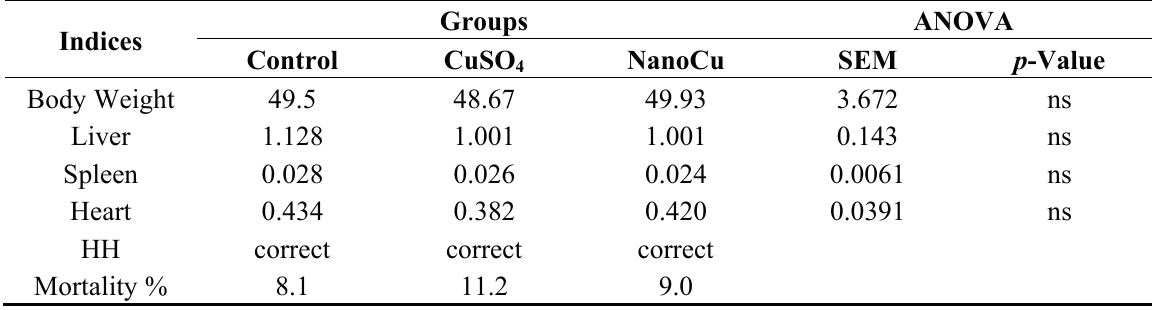
Table 1. Weight of the body and chosen organs, evaluation according to Hamburger–Hamilton development stages (HH) and mortality of chick embryo at 20 day, after in ovo treatment with CuSO 4 and nanoparticles of Cu